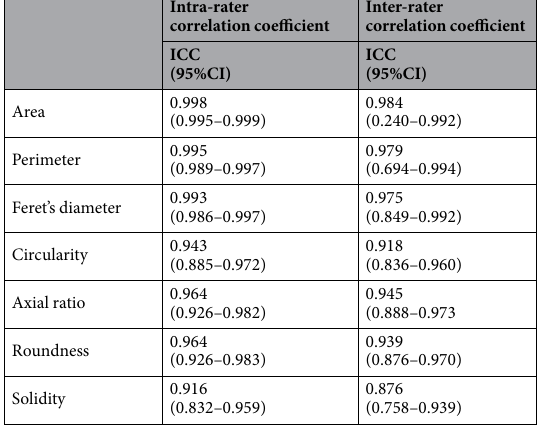
Table 1. Intra-rater correlation coefficient and Inter-rater correlation coefficient of each parameter.